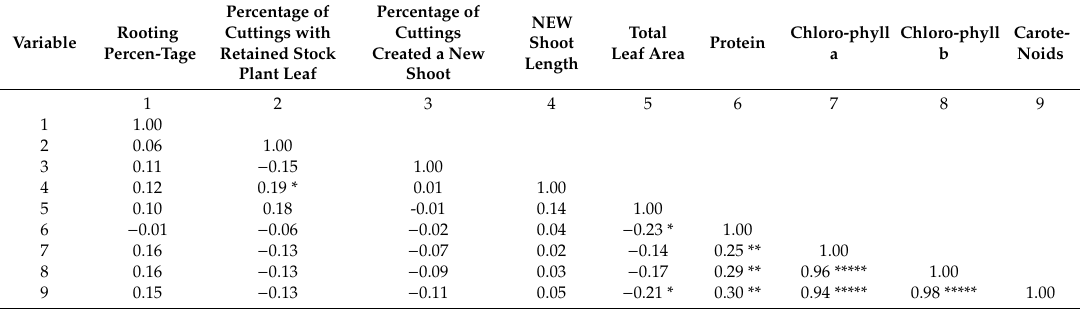
Table 7. Correlations matrices between rooting percentage and growth parameters, pigments, and soluble proteins content for cutting harvesting from shoots 7–14 days after petal shedding in Rosa ‘Maiden’s